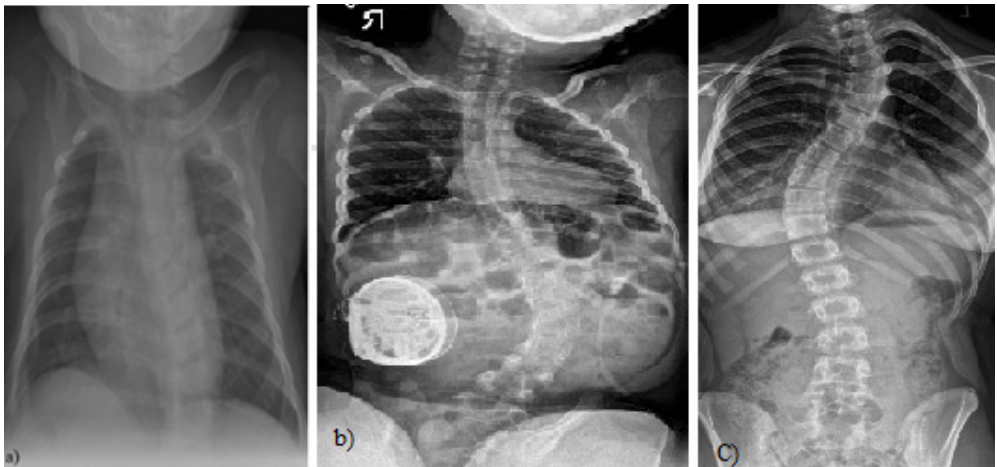
Figure 1. ( a ) A 4-month-old boy born small for gestational age, at 37 weeks, who presented initially with asymmetry of both the left and right aspects of the anterior and posterior chest and confirmed thoracolumbar scoliosis and vertebral anomalies based on plain radiography with a Cobb angle measurement of 30 degrees, (Case courtesy of Sonal Desai, Radiopedia.org, rID: 63310 under Creative Commons License (CC BY 3.0).) [5]; ( b ) X-rays of a girl with juvenile idiopathic scoliosis, (Case courtesy of Dr Jeremy Jones, Radiopaedia.org, rID: 89566 (CC BY 3.0).) [6]; and ( c ) severe left thoracic adolescent scoliosis, (Case courtesy of Dr Jeremy Jones, Radiopaedia.org, rID: 89456 (CC BY 3.0).) [7].